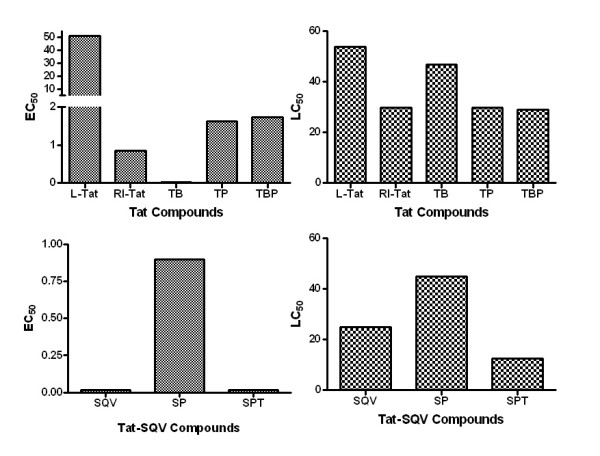
Representative data from MTT assays showing the anti-HIV activity (EC50) of Tat and SQV compounds using MT-2 cells infected with HIV-1 strain Vbu 3 at 0.01 MOI. Cytotoxiciy (LC50) was determined usjng uninfected cells. [TB: R.I.CK(biotin)-Tat9, TP: PEG10k-(R.I.CK-Tat9)8, TBP: PEG10 K-(R.I.CK(biotin)-Tat9)8, SQV: saquinavir, SP: SQV-Cys- PEG3.4 K, SPT: SQV- PEG3.4 K-R.I.CK-Tat9]